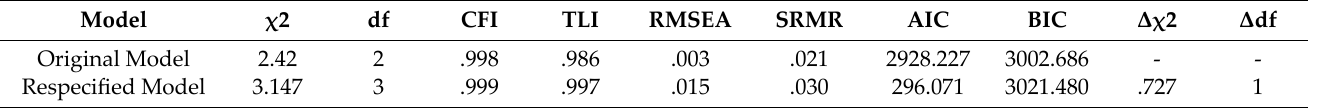
Table 4. Goodness‑of‑fit Indexes and Comparisons of Different Models of the Relation between Chi‑ nese Lexical Tone Awareness and English Word‑level Literacy among Grade 4 Chinese Learners of